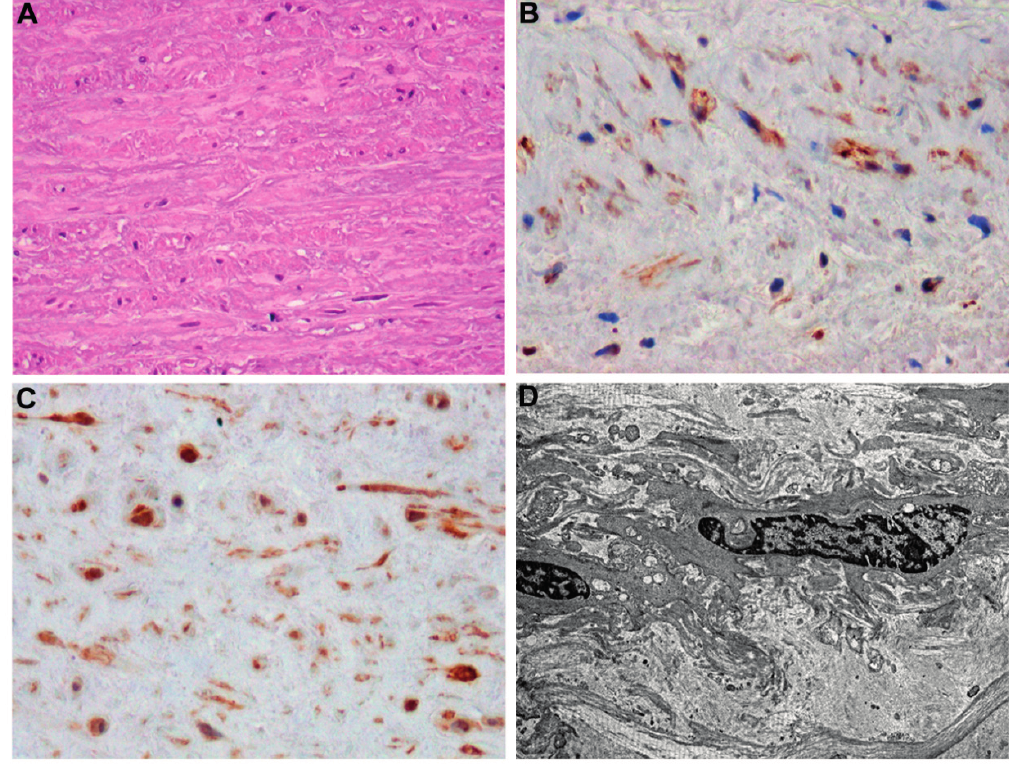
Figure 1. Aortopathy and diabetes: microscopic aspects. ( A )